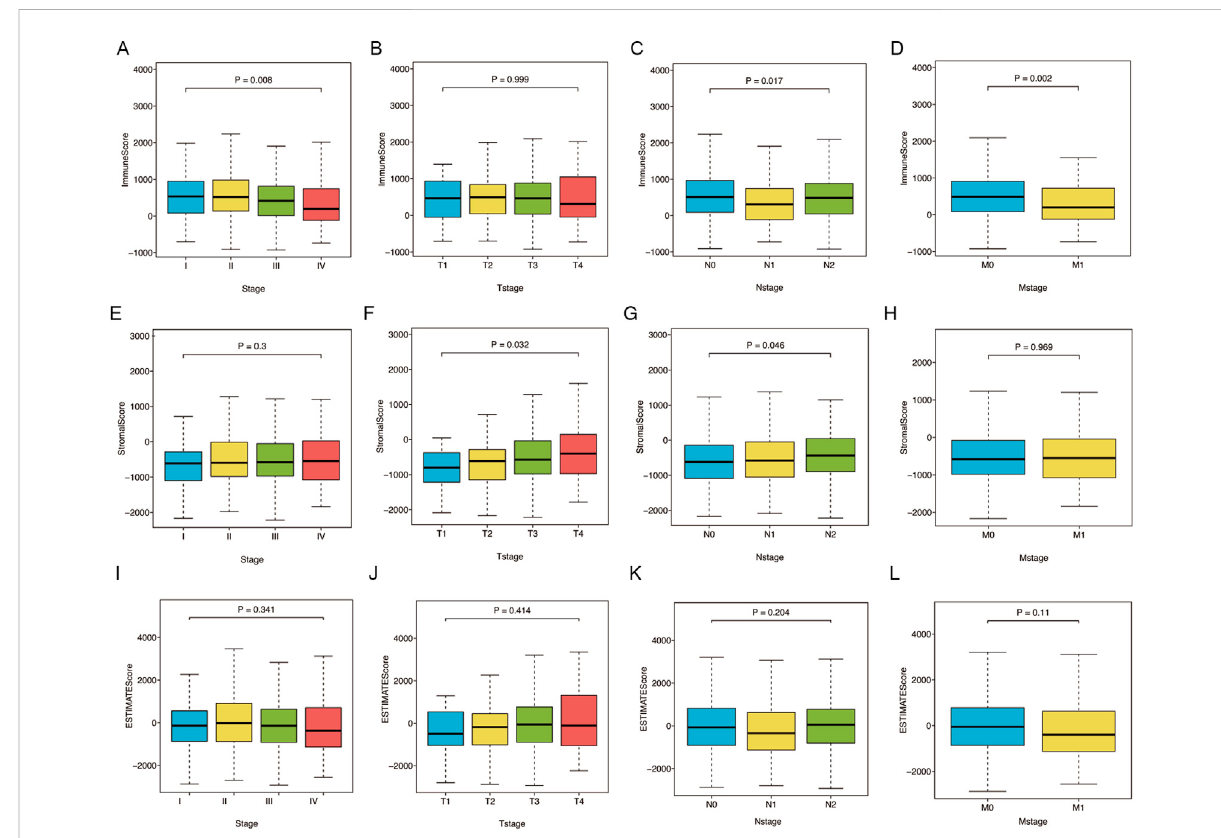
FIGURE 1 Relations of ImmuneScore, StromalScore, and ESTIMATEScore with clinicopathological stages. (A – D) Relations of ImmuneScore with pathological stage ( p = 0.008), T stage ( p = 0.999), N stage ( p = 0.017) and M stage ( p = 0.002). (E – H) Relations of StromalScore with pathological stage( p =0.3),Tstage( p =0.032),Nstage( p =0.046)andMstage( p =0.969). (I – L) RelationsofESTIMATEScorewithpathologicalstage( p =0.341), T stage ( p = 0.414), N stage ( p = 0.204) and M stage ( p = 0.11). Statistical difference of four groups was compared by the Kruskal – Wallis